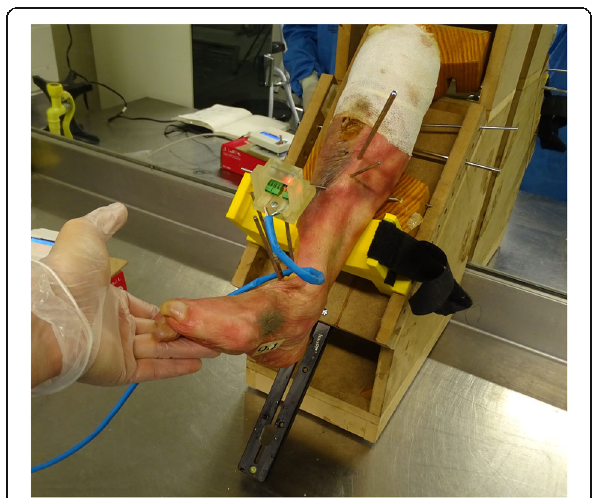
Fig. 4 Ankle in a neutral position for system calibration